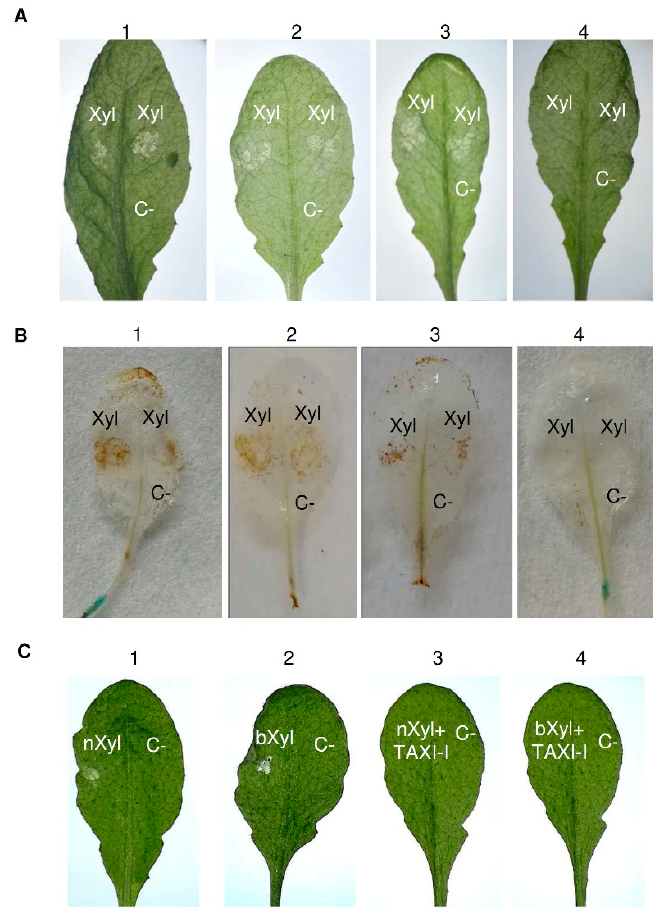
Figure 4. Analysis of necrosis and H 2 O 2 production induced by BcXyn11a xylanase in Arabidopsis thaliana tissues and capacity of TAXI-I to limit the BcXyn11a effect in transgenic TAXI-I and wild-type (Col-0) leaves. ( A ) Necrotizing activity of BcXyn11a (Xyl) in infiltrated A. thaliana leaves of (1) pBI:GUS; (2) TAXI-I line 1; (3) TAXI-I line 2; (4) TAXI-I line 3 transgenic lines. ( B ) H 2 O 2 induction by